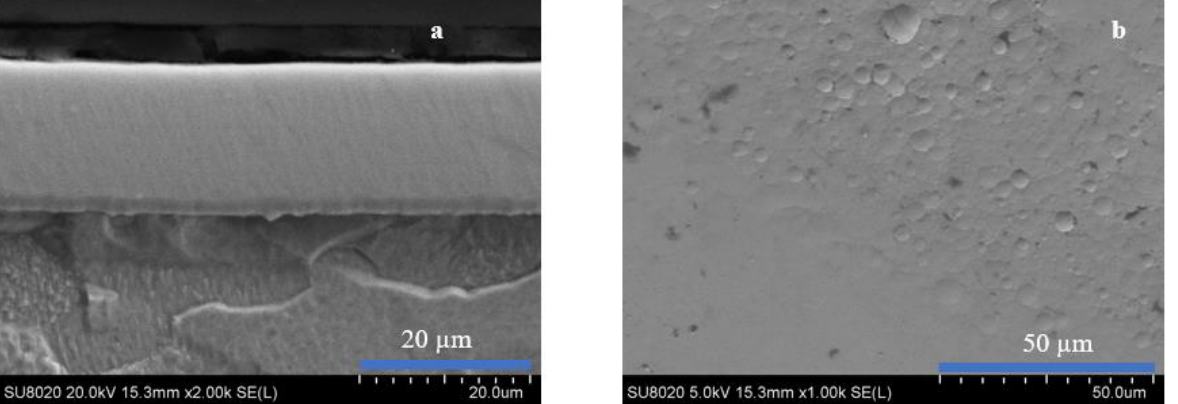
Figure 4. Cross-section ( a ) and surface ( b ) morphologies of the ENB deposit annealed at 300 ◦ C for 4